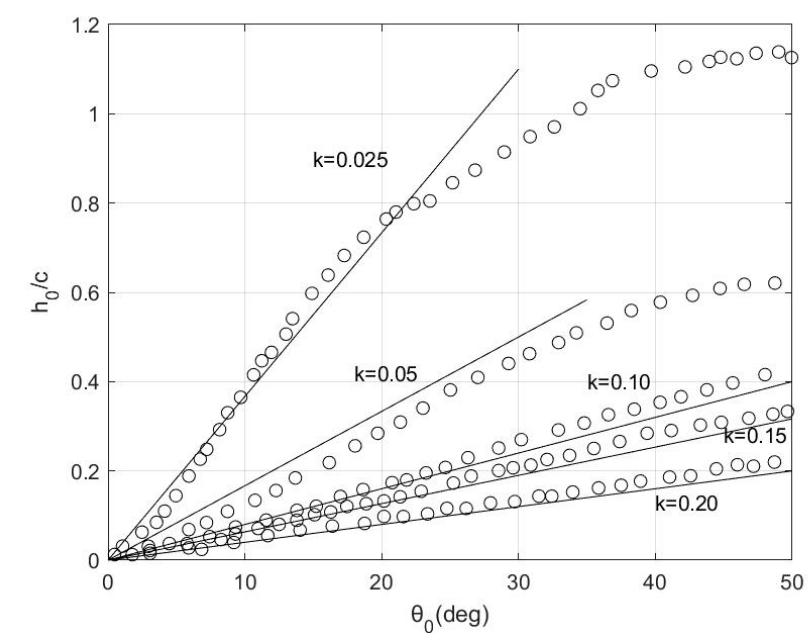
Figure 13. Dimensionless heave amplitude (normalized by using chord length) with as a function of pitching amplitude a 0 for different reduced frequencies k = 0.025,0.05,0.1,0.125,0.15,0.2. The results obtained by frequency-domain model are indicated with solid lines and the experimental data using